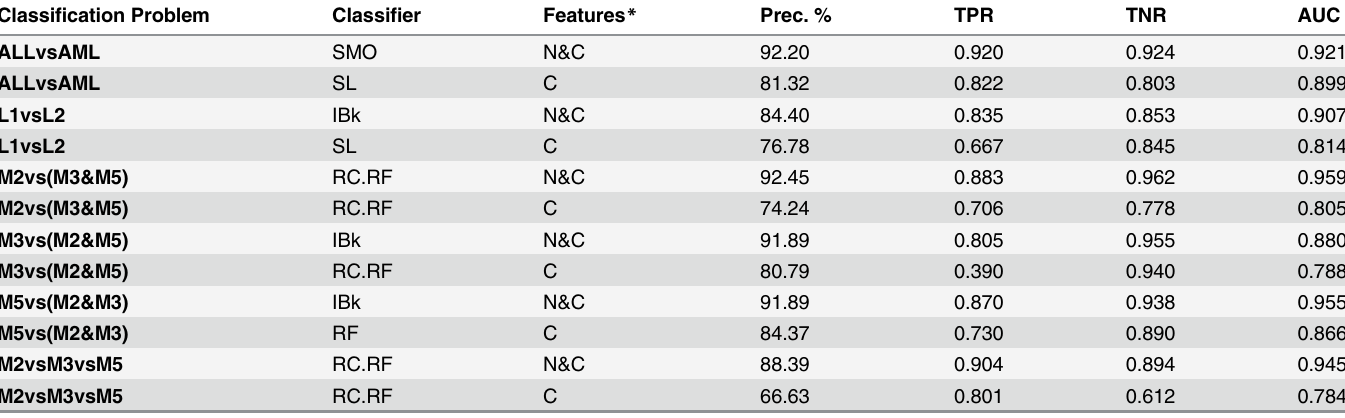
Table 5. Results of the best classifier for each type or subtype of acute leukemia cells.